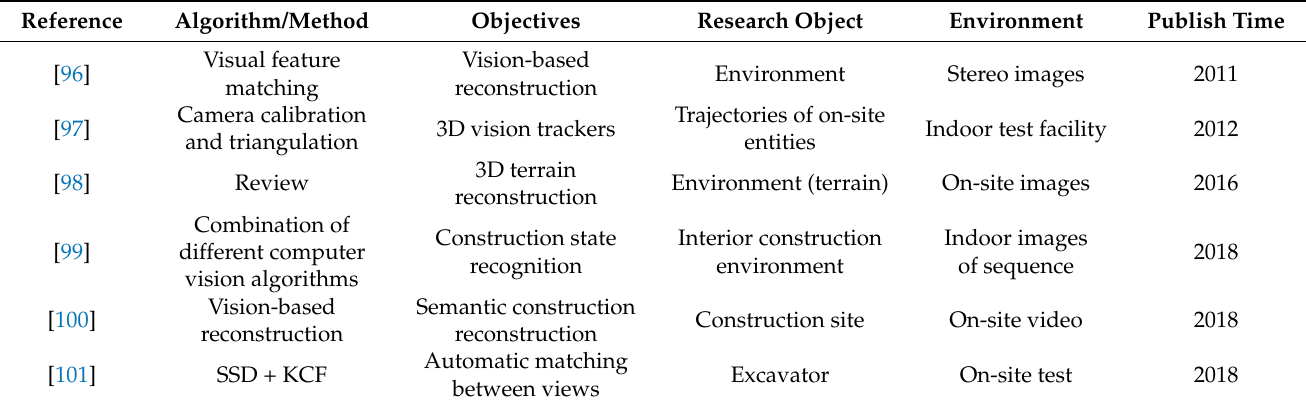
Table 6. Computer vision applications in 3D reconstruction.